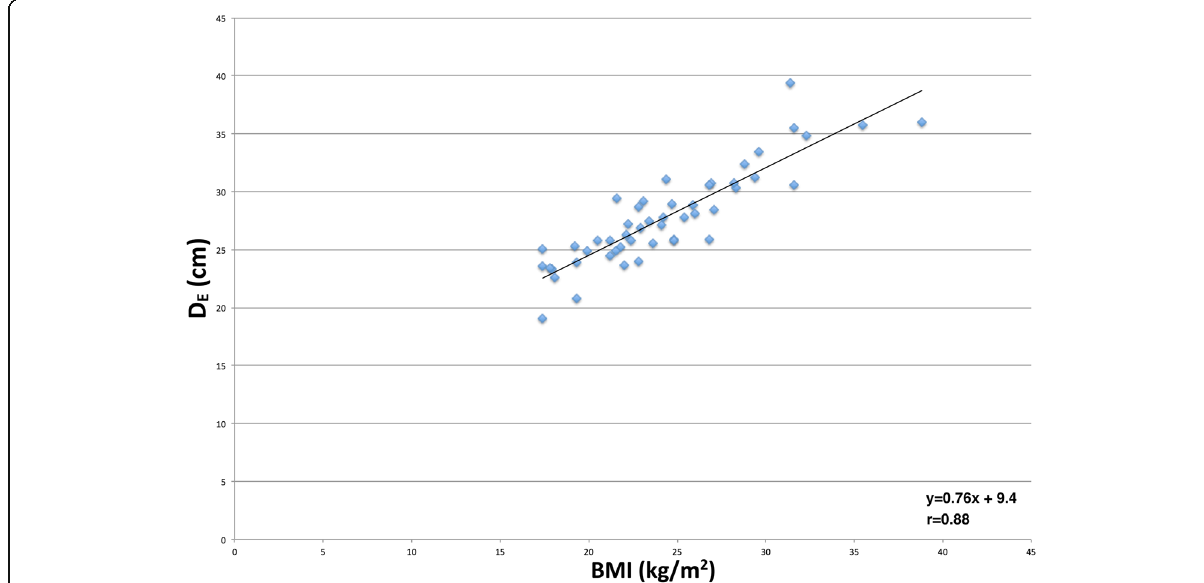
Fig. 4 Scatterplot of body mass index (BMI) as a function of effective diameter. Linear regression trend line equation: D E = 0.76( BMI ) +